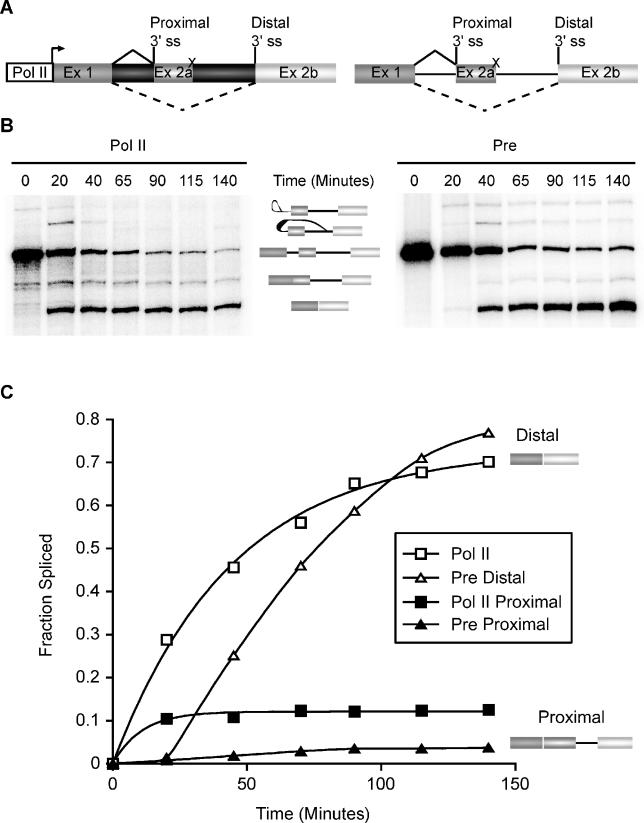
The Link between Pol II Transcription and Splicing Influences Alternative 3′ Splice-Site Choice(A) Diagrams of the
wt14 minigenes with duplicated 3′ splice sites, either as a DNA template preceded by a Pol II promoter (left) or the pre-synthesized RNA transcript (right). The proximal exon (exon 2A) does not contain a 5′ splice site, is significantly shorter than the distal exon, and lacks exonic splicing enhancers. (B) Representative autoradiograms show the time course of the transcription/splicing UTP chase experiment (left) and the splicing profile of pre-synthesized RNA transcripts (right). The pre-mRNA transcript, spliced products, and intermediate lariat bands are indicated. (C) Quantitation of distal and proximal spliced product formation from (B).